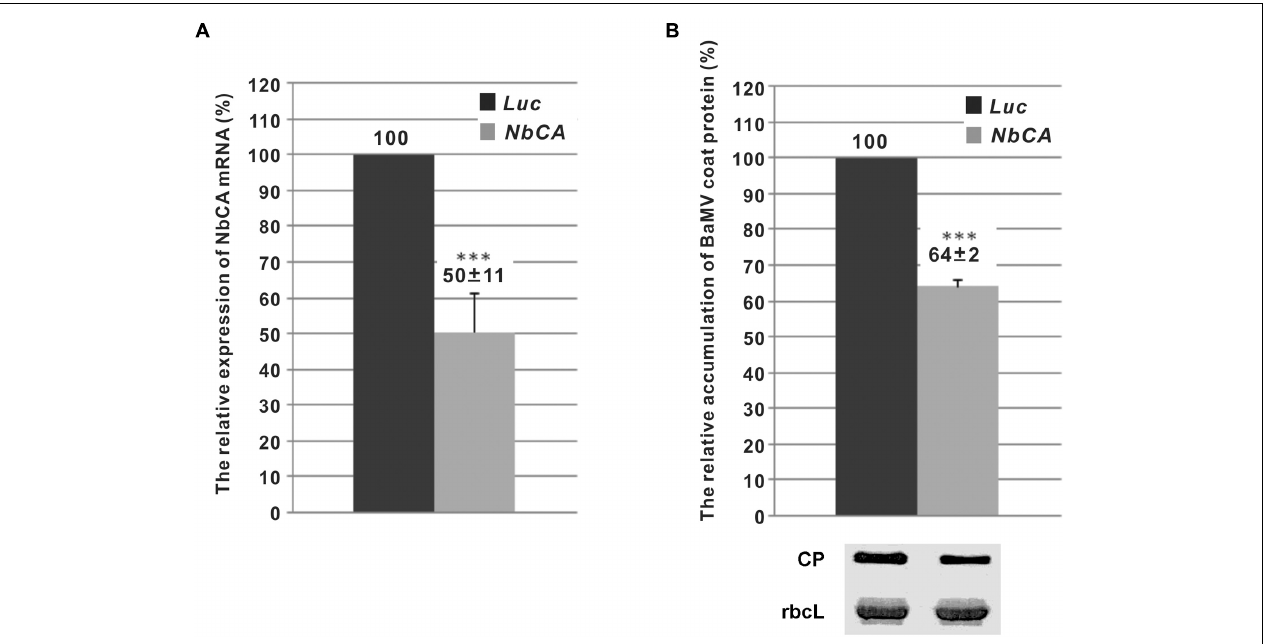
FIGURE 1 | The relative expression of NbCA in Nicotiana benthamiana leaves with NbCA- knockdown and the accumulation of Bamboo mosaic virus (BaMV). (A) Real-time quantitative RT-PCR analysis of the efficiency of NbCA knockdown in NbCA - and Luc -knockdown leaves. The numbers above each bar are the mean relative expression of NbCA with the standard error obtained from at least three independent experiments. (B) Western blot analysis of the relative accumulation of BaMV coat protein in Luc - and NbCA -knockdown N. benthamiana leaves after 5 days post-inoculation (dpi). Total proteins were extracted from seven individual plants ( n = 7). The numbers are the mean levels of coat protein with the standard error obtained from three independent experiments. The accumulation of BaMV coat protein in Luc -knockdown plants was set to 100%. Luc , luciferase -knockdown plants; NbCA , NbCA -knockdown plants; CP, coat protein; rbcL, Rubisco large subunit used as a loading control. ∗∗∗ p < 0.001 by Student’s t -test.